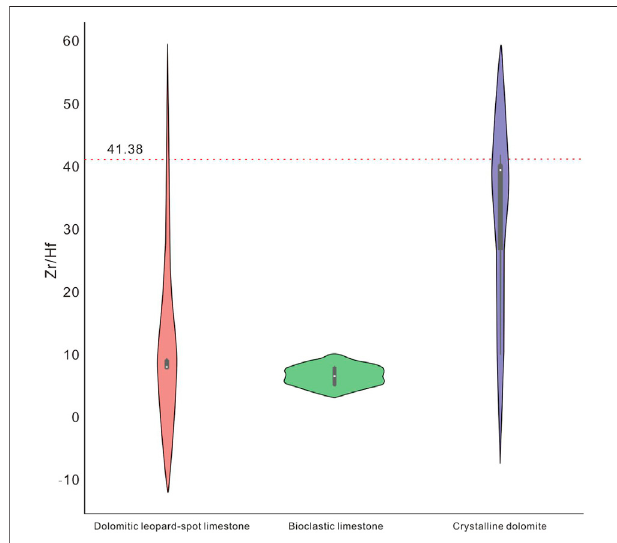
FIGURE 7 | Distribution of the Zr/Hf ratio of dolomite of Qixia Formation in the study area.